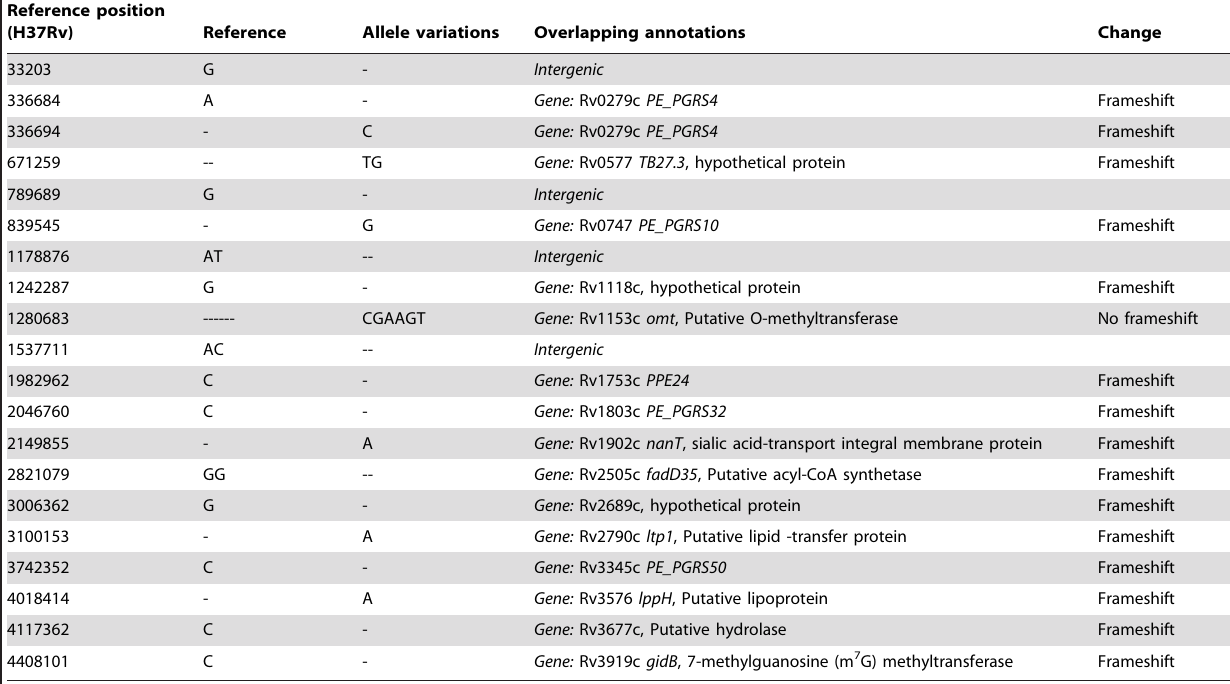
Reference position